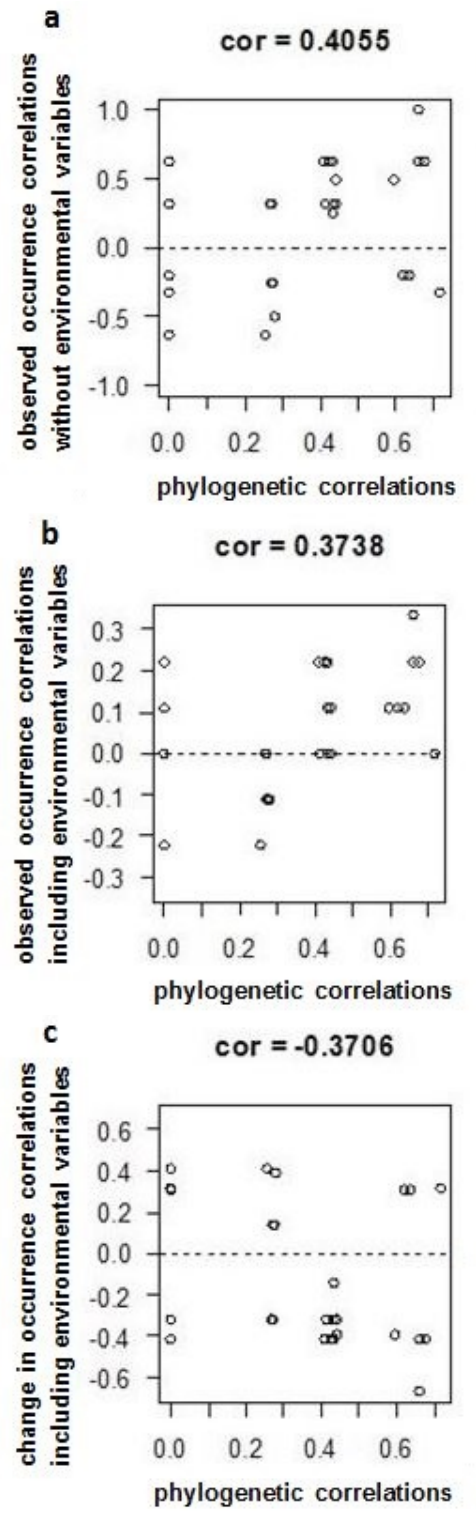
Fig 4 . Influence of environmental factors on community structure. Shown are correlations of pairwise species co-occurrence and pairwise phylogenetic correlations a) without environmental variables, b) including environmental variables,and the c) change in species co-occurrence once environmental variables are taken into account. There were no significant results a) without and b) with environmental variables included (P > 0.05). Also c), the changes in correlation were not significant either (P >